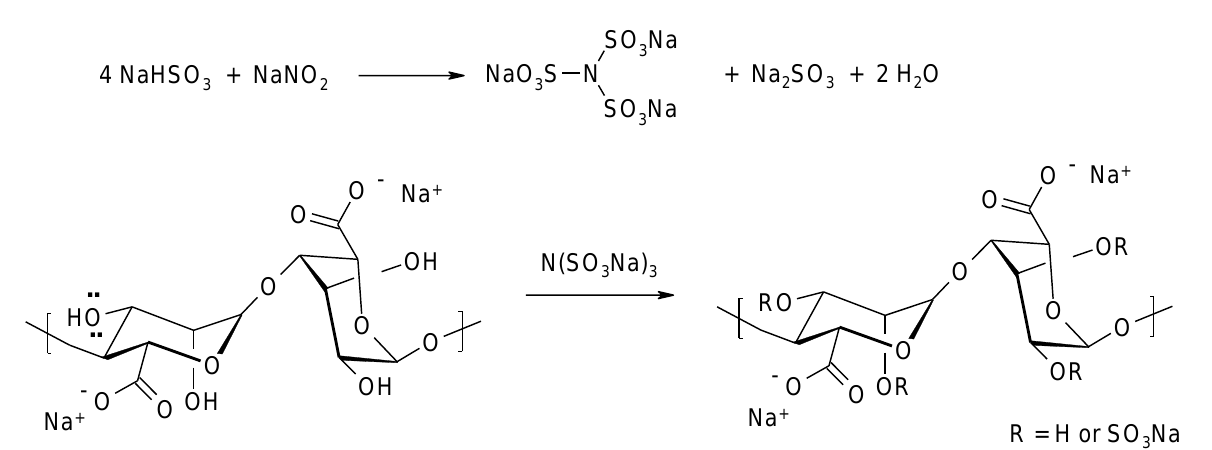
Figure 10. T Formation of sulphate derivatives of alginates using a mixture of NaHSO 3 and NaNO 2 . The DS value was 1.87 for a reaction performed at 40 ◦ C, with a ratio of